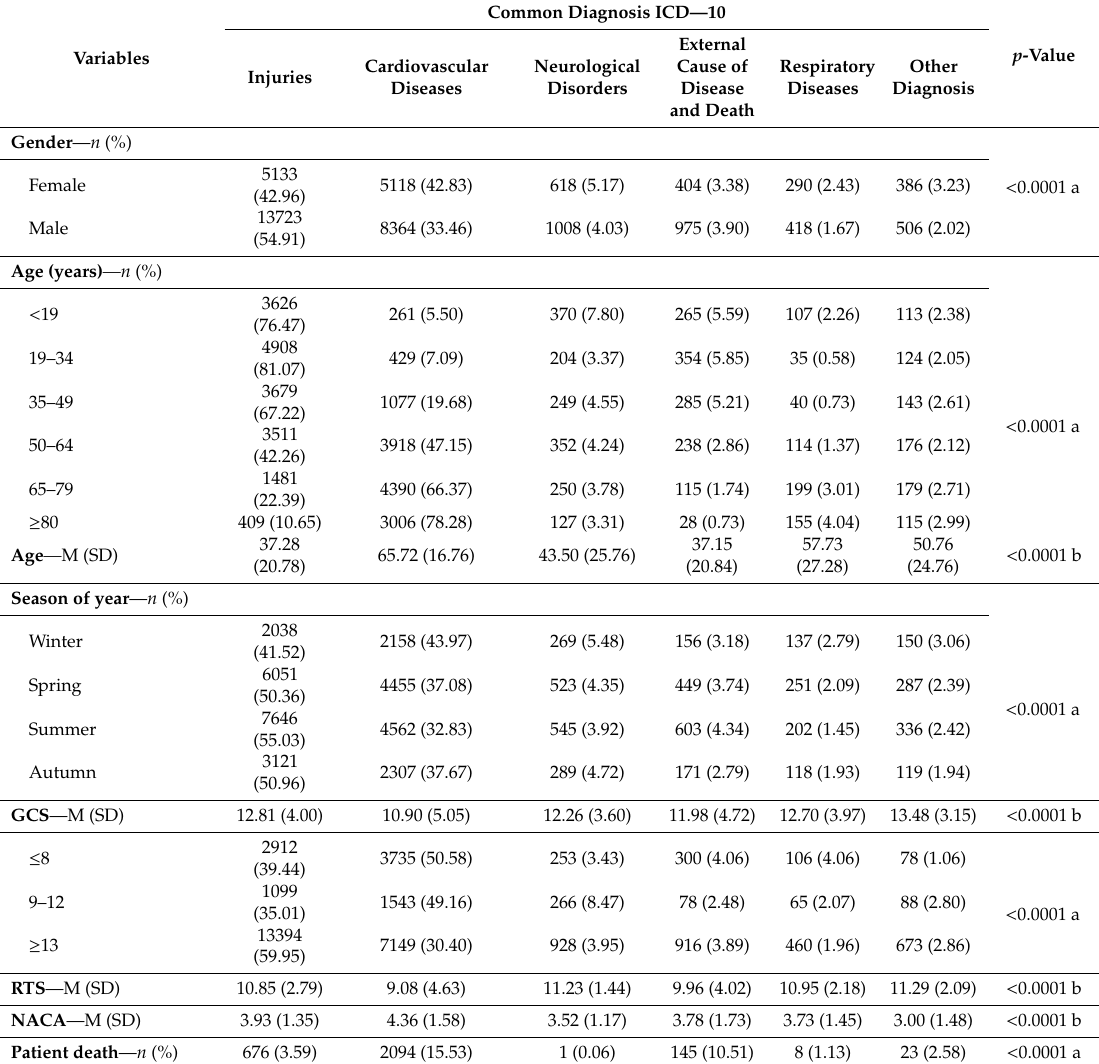
Table 3. Statistical analysis of most common diagnosis in correlation with patient characteristics and clinical